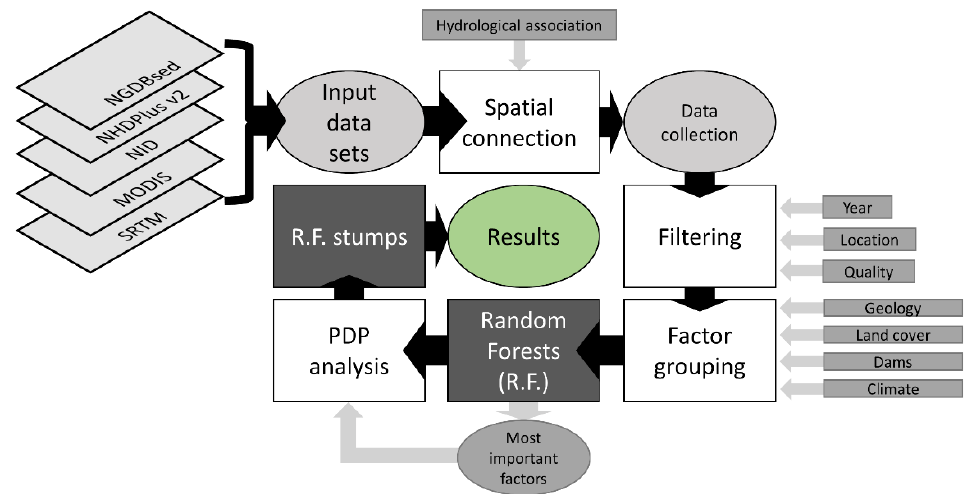
Figure 1. The workflow of the presented study begins with the several data input sets and moves along the spiral until reaching the results.